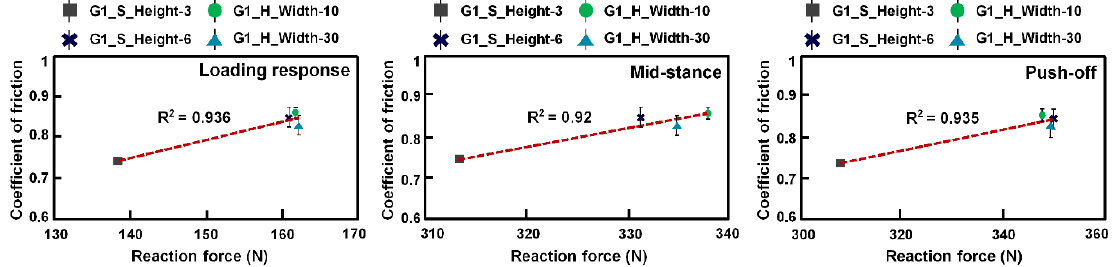
Figure 7. The relationship between the FE predicted ground reaction force of group one and the experimentally measured coefficient of friction.